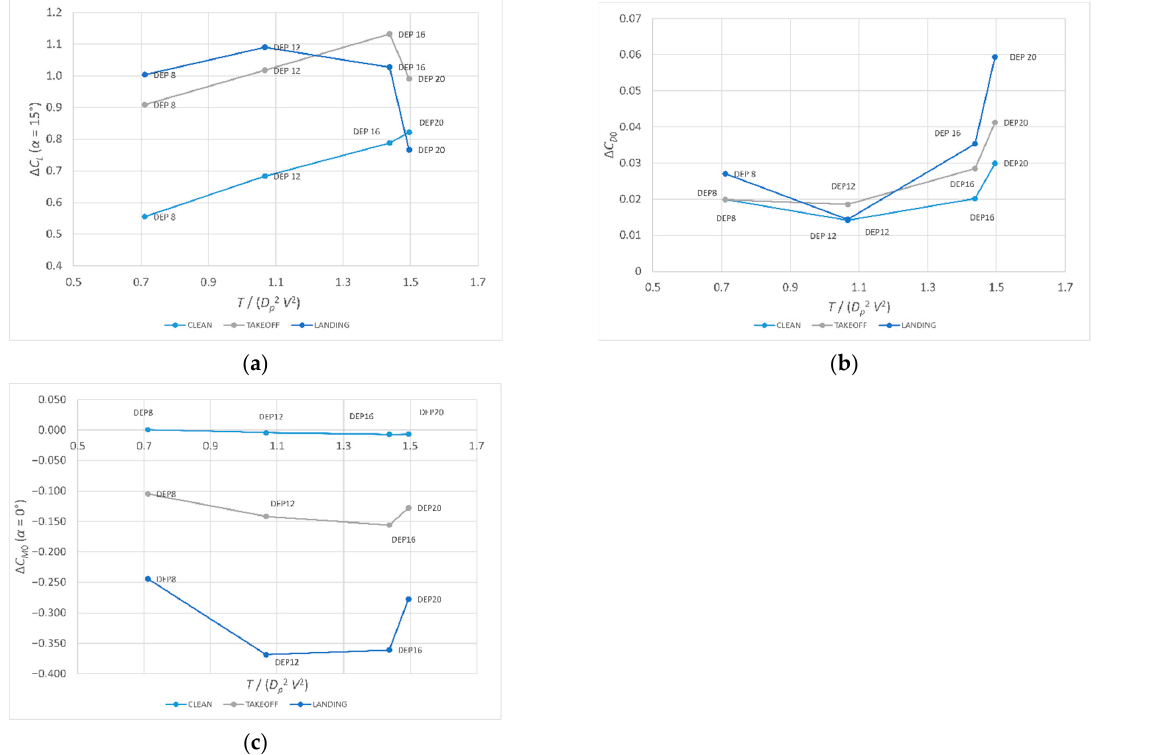
Figure 25. Effects of high-lift propellers on a typical 40-passenger regional turboprop wing, presented as difference values with respect to the unblown isolated wing, AR = 11.07, M = 0.15, Re = 7.6 × 10 6 , DEP 8, DEP 12, DEP16, and DEP 20 configurations: ( a ) lift coefficient change Δ C L at α = 15°; ( b ) parasite drag coefficient change Δ C D0 ; ( c ) pitching moment coefficient change Δ C M0 at α = 0°.